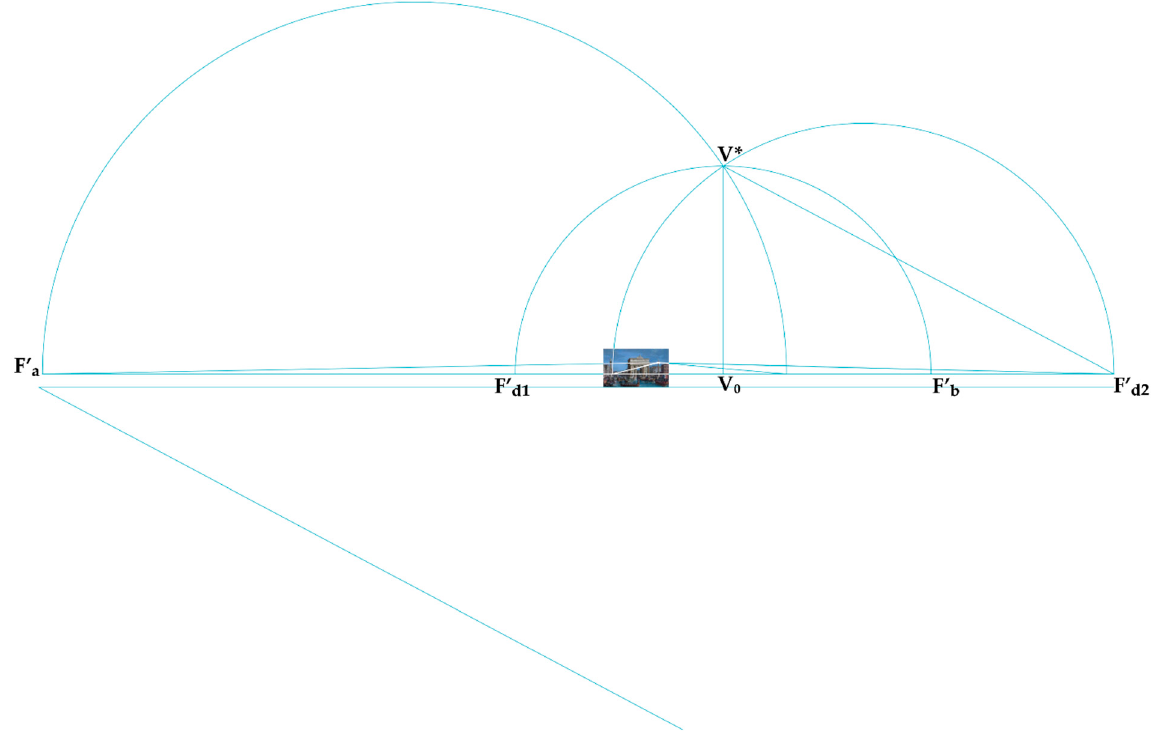
Figure 12. Determination of the position of the center of view.